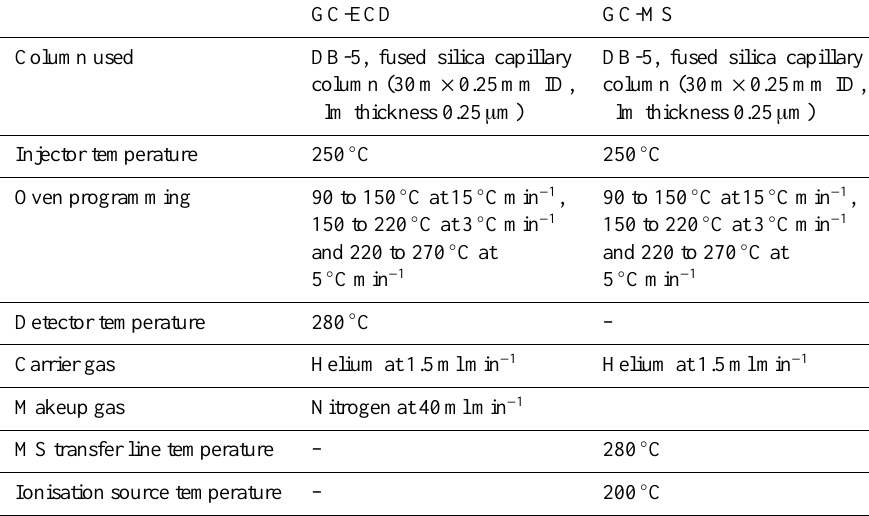
Table 1. Operating conditions used for the operation of GC-ECD and GC-MS.